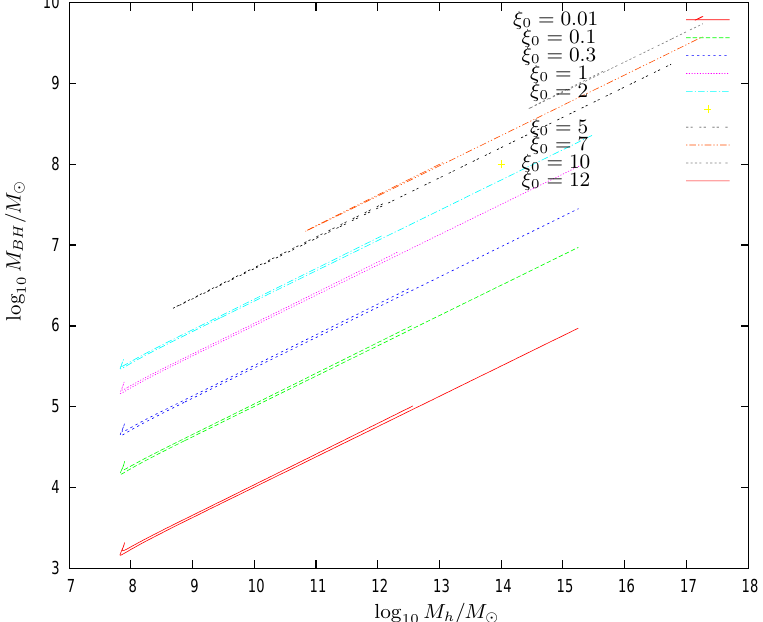
FIG. 7: The galaxy temperature log ( T 0 / K) vs. the constant A of the chemical potential behaviour at the origin, for fixed 10 values of ξ 0 . As for the halo mass M h , the galaxy temperature T 0 increases with ξ 0 at fixed A . T 0 increases when the absolute value of A increases at fixed ξ 0 > 0. In the absence of a black hole, the galaxy temperature T 0 tends to zero for A exact Fermi degenerate state) while in the presence o f a central black hole, we find that T 0 is always larger than a minimal non-zero value T min 0 non-zero value T min given by Equation (84). 0